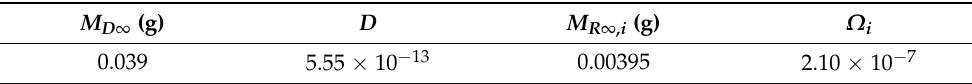
Table 4. Water uptake